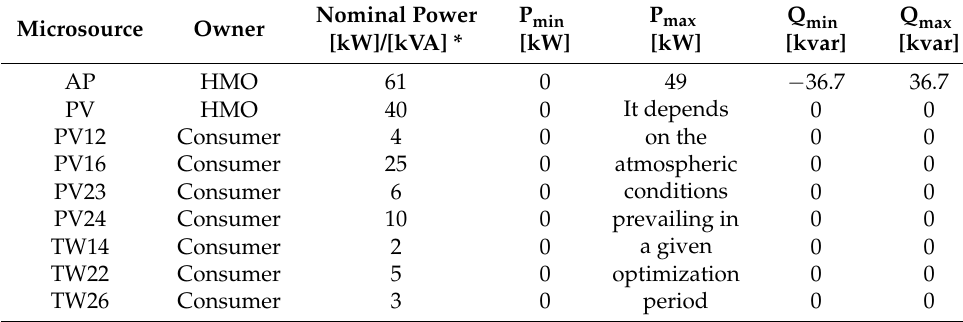
Table 2. Technical data of the microsources installed in the hybrid test